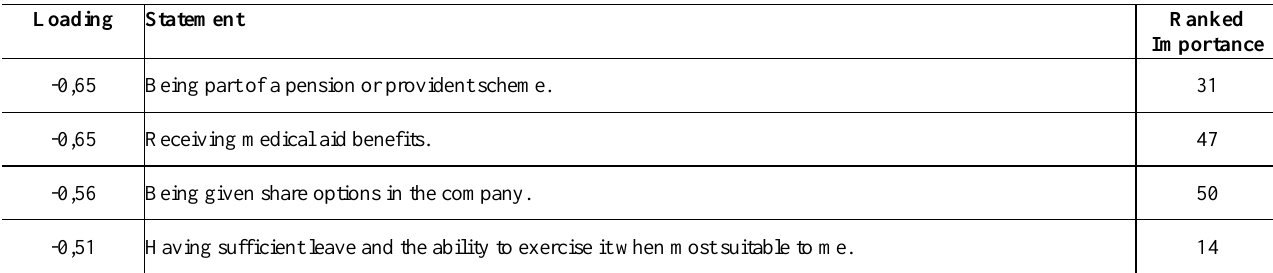
Table 7: Variables associated with factor five